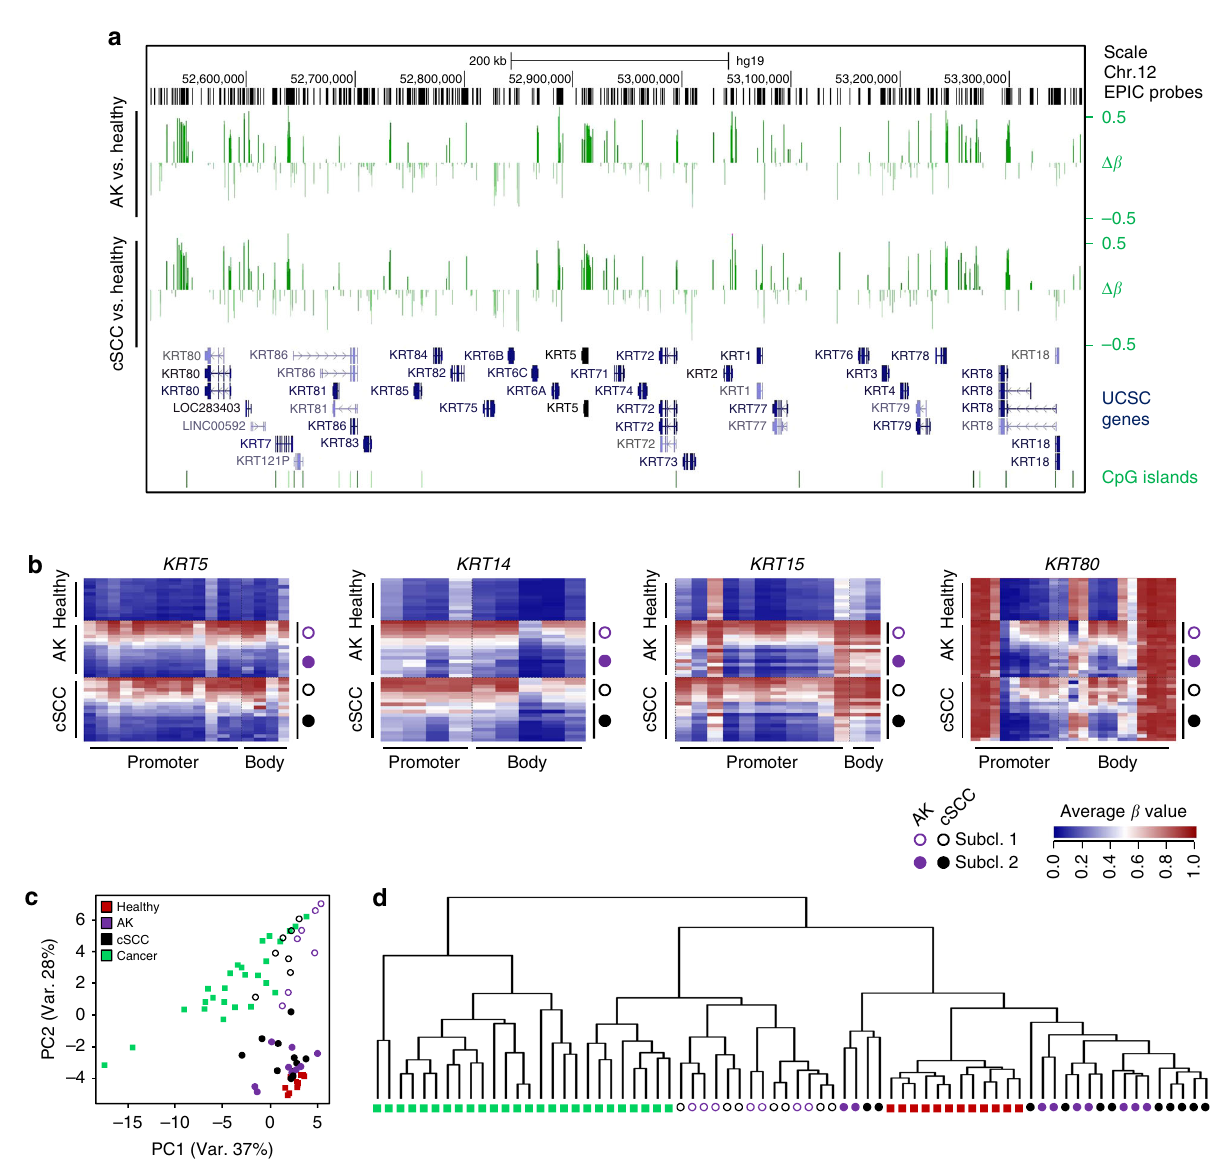
Fig. 5 A speci fi c methylation signature at keratin gene clusters identi fi es two distinct subclasses of AK/cSCC. a UCSC genome browser tracks showing signi fi cant DNA methylation differences ( Δ β , P < 0.05, F -test, vertical green lines) at the keratin gene cluster on chromosome 12 for AK (upper part) and cSCC (lower part) in comparison to healthy epidermis. b Speci fi c DNA methylation patterns of the genes encoding keratins K5, K14, K15, and K80 ( KRT5 , KRT14 , KRT15 , and KRT80 , respectively). Heatmaps show DNA methylation levels (in β values, from blue ( = 0) to red ( = 1)) of probes (columns) located in the promoter and gene body, for individual healthy, AK, and cSCC samples (rows). Filled and empty circles denote the two distinct subclasses of AK ( purple ) and cSCC ( black ), respectively. c Principal component analysis of healthy, AK, and cSCC epidermis samples based on 1364 keratin-associated methylation probes. For comparisons, keratin methylation patterns from 26 additional tumor entities were also included. d Hierarchical clustering of